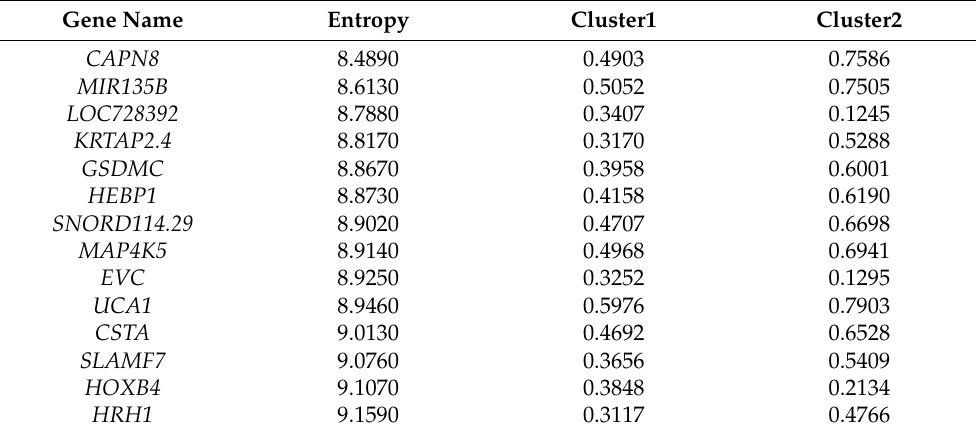
Table 1. Specific genes associated with PAAD subtypes.